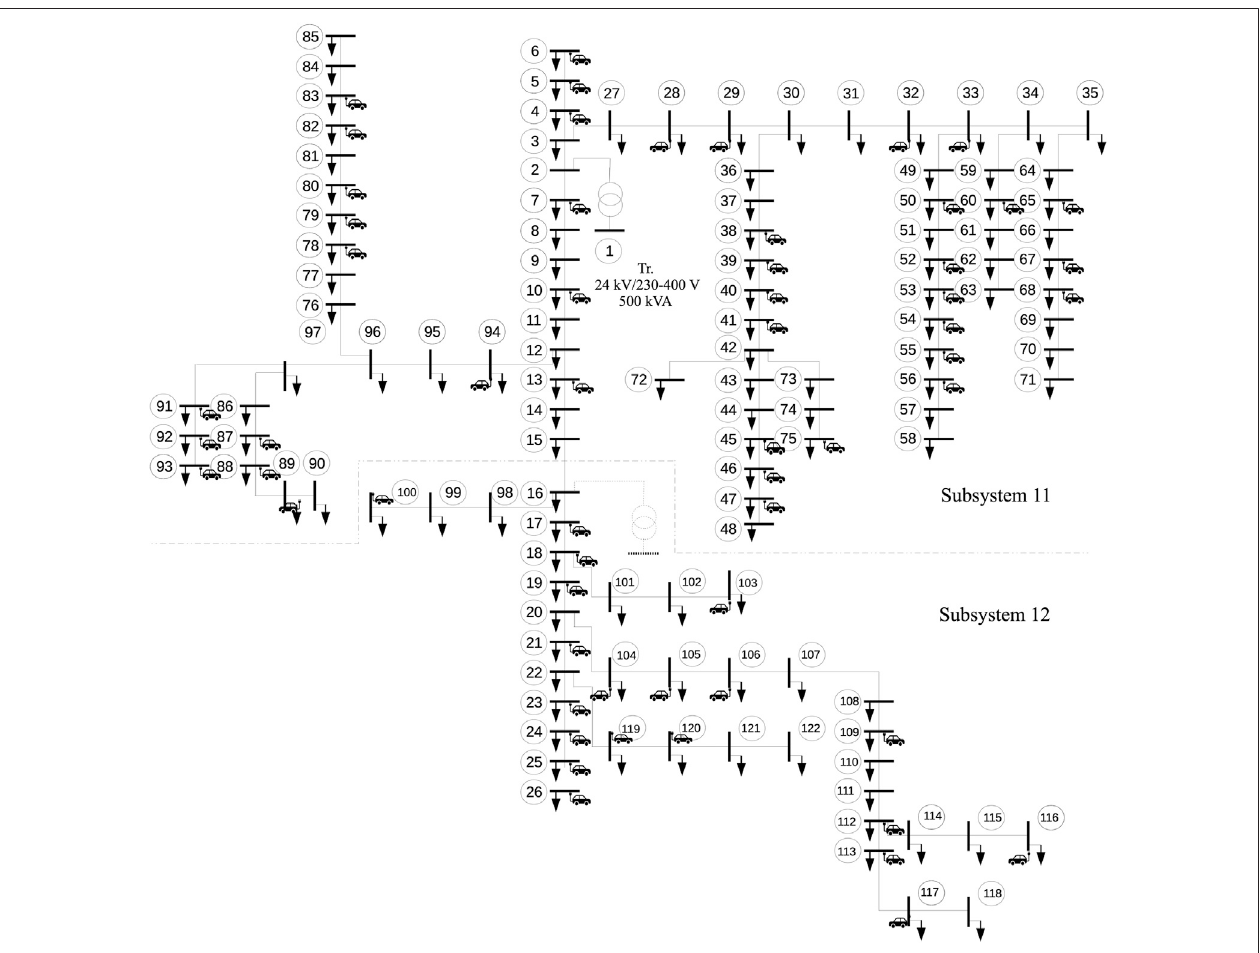
FIGURE 5 | Low-voltage distribution system with 122 buses with EV loads.